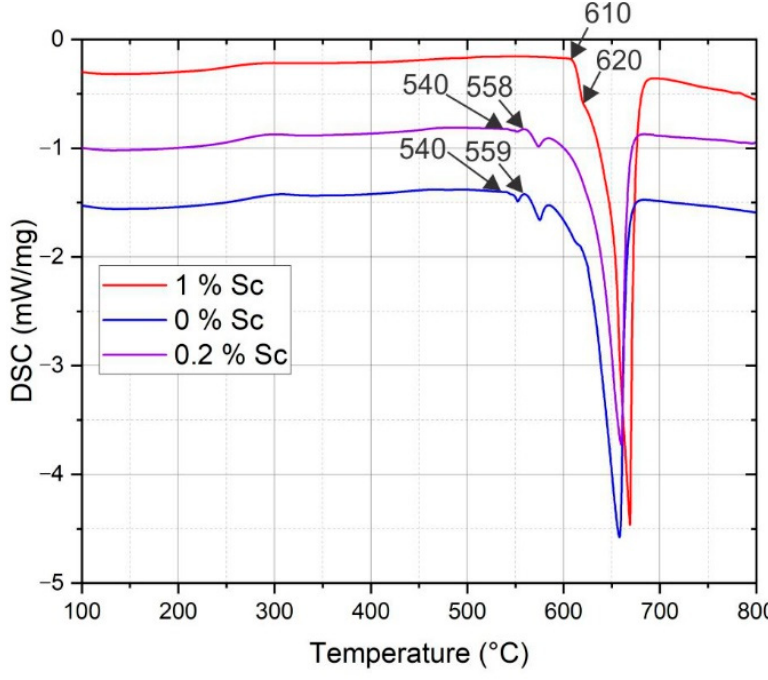
Figure 3. The heating DSC curves for the investigated alloys.